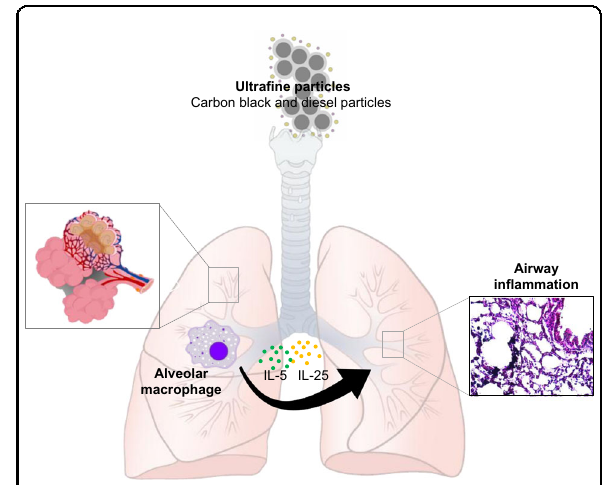
Fig. 4 Th2 cytokine changes in macrophages exposed to TiO 2